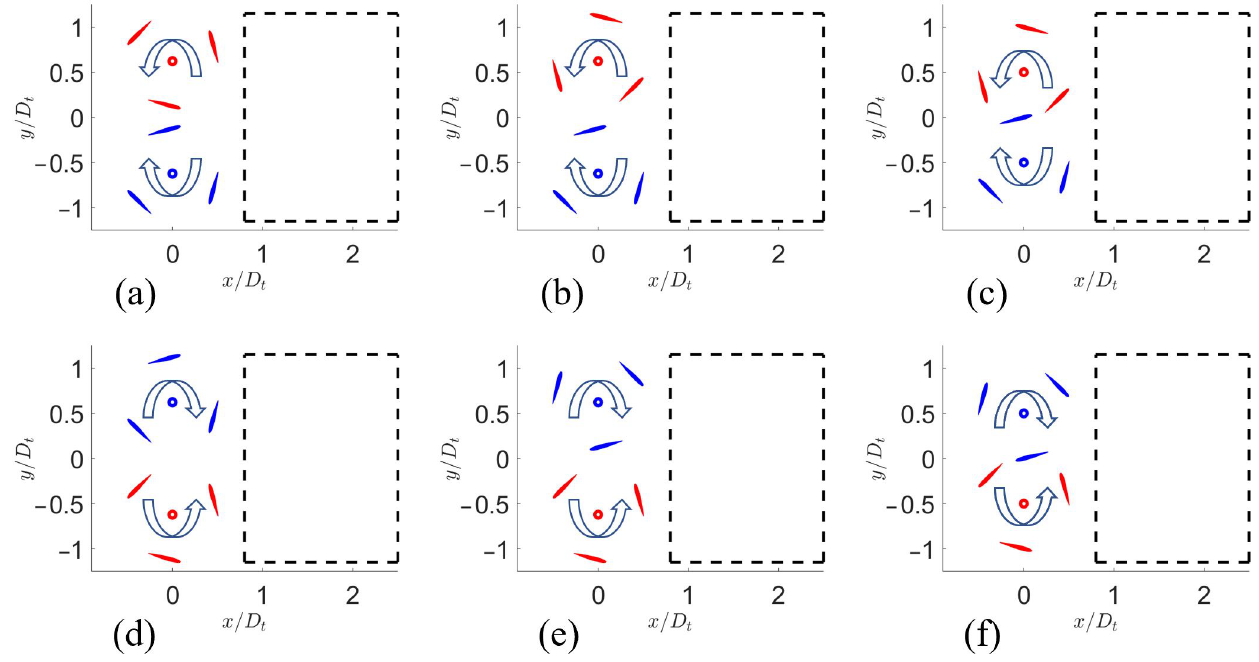
Figure 4. Different turbine configurations used in the near-wake measurement experiments: ( a ) forward counter-rotating at ∆Φ = 0 ◦ , ( b ) forward counter-rotating at ∆Φ = 60 ◦ , ( c ) forward overlapping at ∆Φ = 60 ◦ , ( d ) backward counter-rotating at ∆Φ = 0 ◦ , ( e ) backward counter-rotating at ∆Φ = 60 ◦ , and ( f ) backward overlapping at ∆Φ = 60 ◦ . The red and blue circles illustrate the turbine T1 and T2 rotational center correspondingly. The flow measurement areas are enclosed inside the black dashed